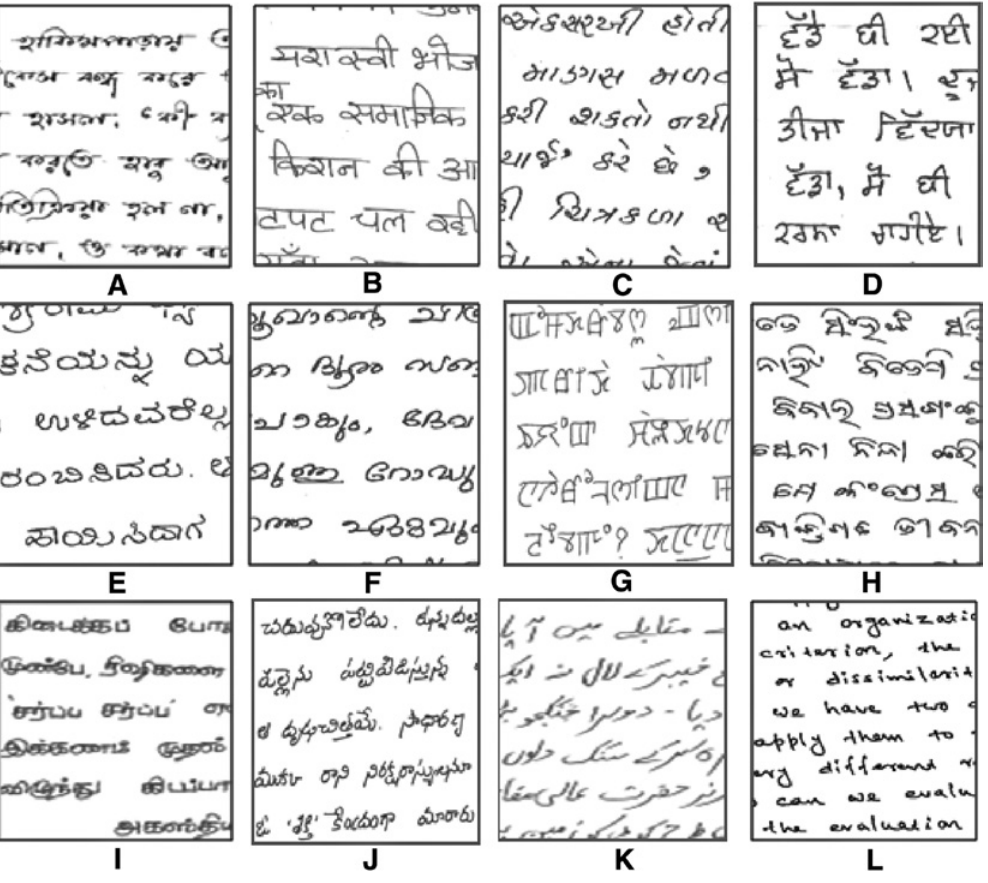
Figure 4: Samples of Text Block Images, Obtained at Second-Level Quad-Tree-Based Decomposition Scheme, Written in (A) Bangla , (B) Devanagari , (C) Gujarati , (D) Gurumukhi , (E) Kannada , (F) Malayalam , (G) Manipuri , (H) Oriya , (I) Tamil , (J) Telugu , (K) Urdu , and (L) Roman